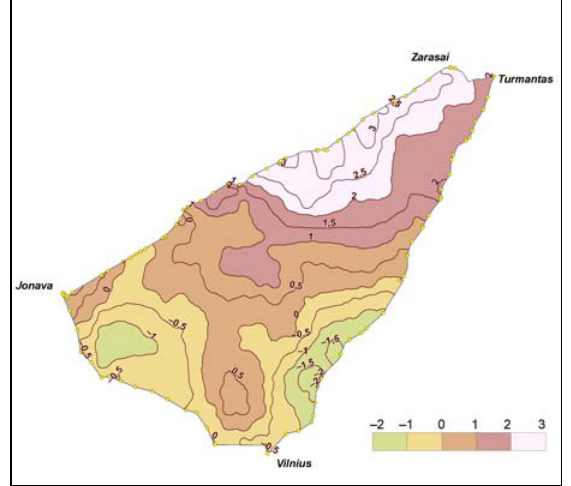
5 pav. Pagal (17) regresin į model į prognozuotas dabartinis tektoninis fonas (judesi ų grei č iai mm per metus) Fig 5. The present tectonic background (movements mm per year) according to the regression model (17)